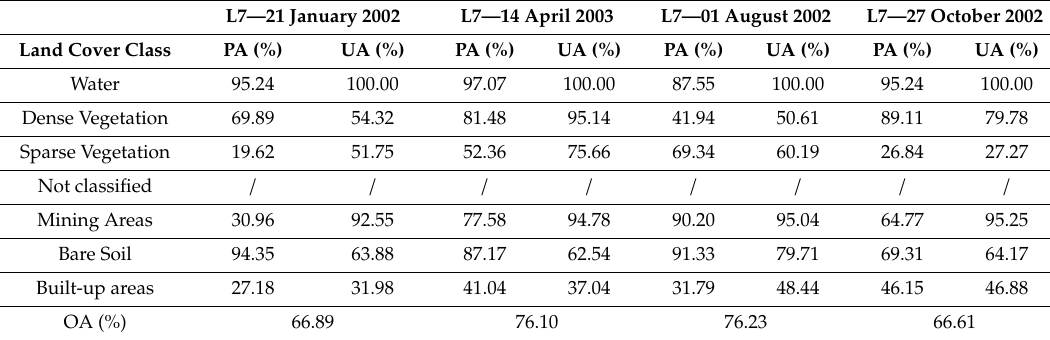
Table 10. OA, PA, and UA obtained through the application of Normalized Di ff erence Bareness Index (version 2) (NDBIaI2) on the data acquired by Landsat 7 mission. UA, user’s accuracy; PA, producer’s accuracy; OA, overall accuracy.